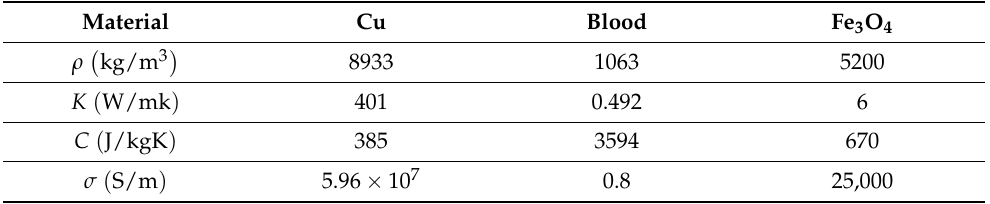
Table 2. The properties of ferro nanoparticles, copper and human blood